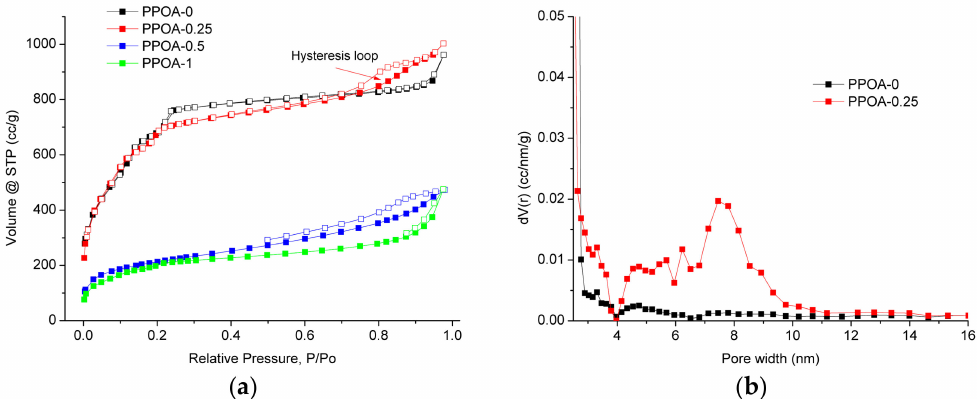
Figure 2. N 2 adsorption–desorption isotherms for PPOA-0, PPOA-0.25, PPOA-0.5, and PPOA-1 ( a ), and the pore size distribution curves for PPOA-0 and PPOA-0.25, which were analyzed by the NL-DFT method ( b